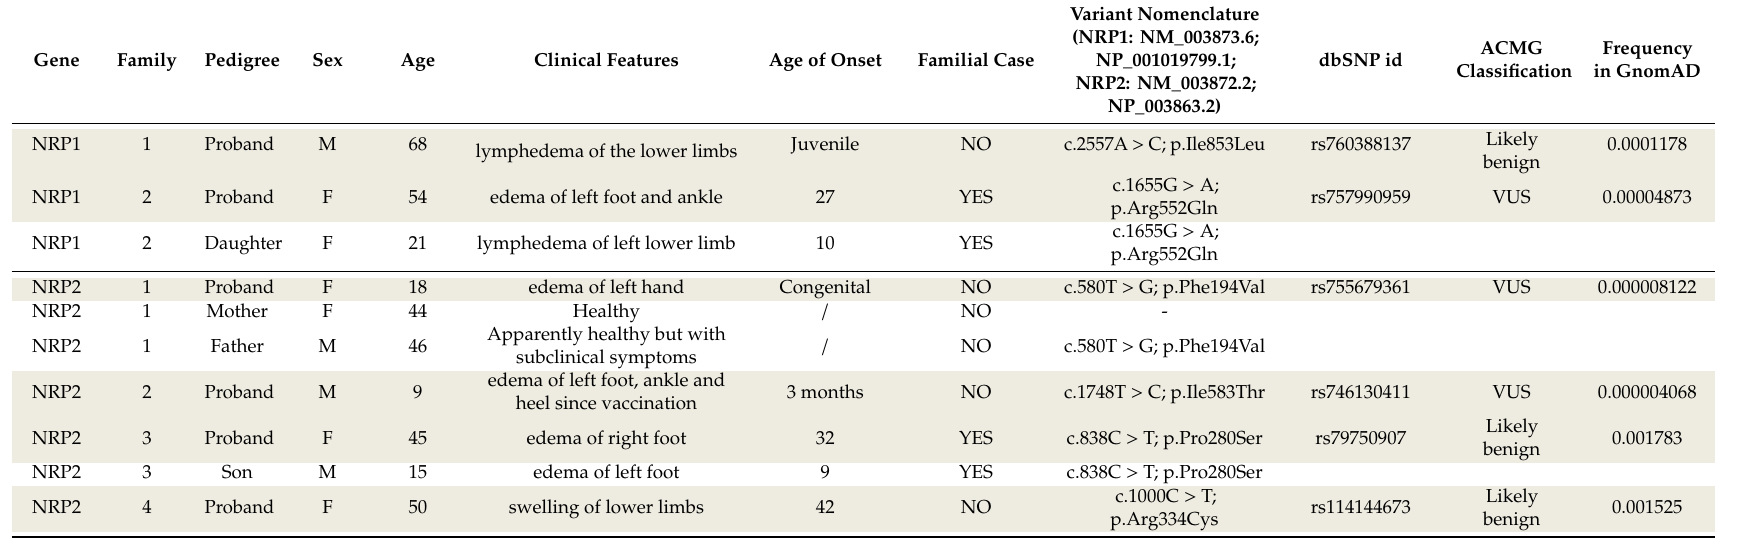
Table 3. Clinical features of probands (grey background) and family members with variants in the NRP1 and NRP2 genes. Abbreviations: M = male, F = female and ACMG = American College of Medical Genetics and Genomics. VUS: variant of unknown